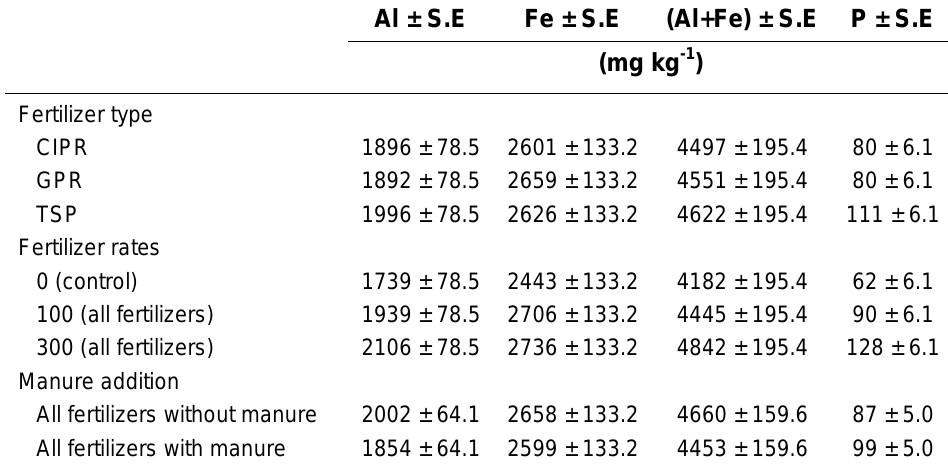
Effect of Treatments on Ammonium Oxalate (pH=3.0) – Extractable Al, Fe, and P from the Field-Sampled